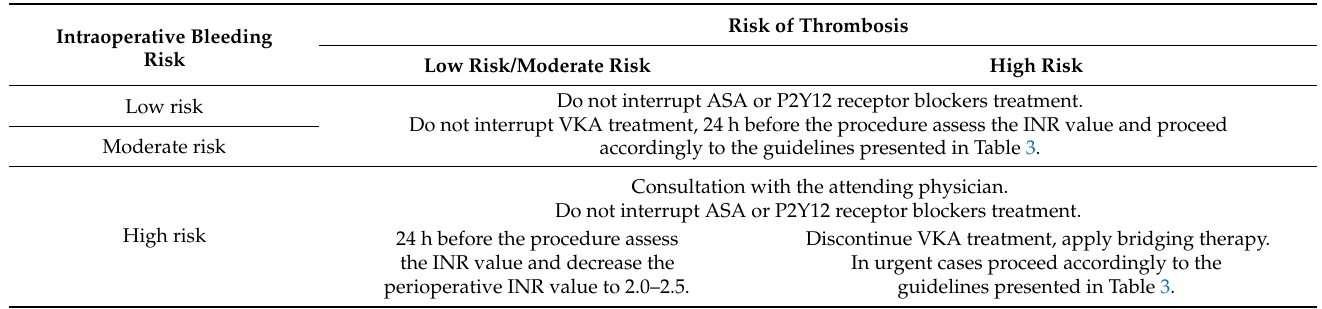
Table 6. The table shows the management regimen for patients on combination therapy: VKA/ASA,